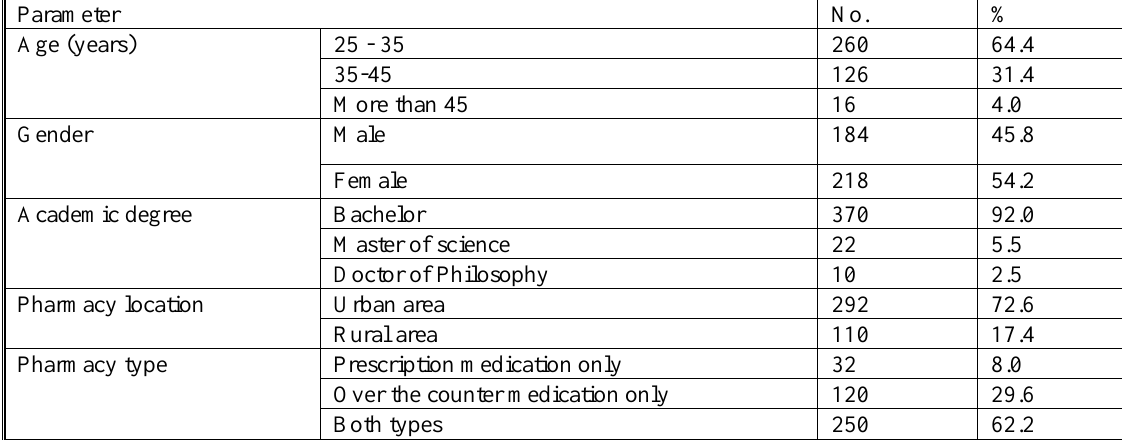
Table 2. General information of pharmacists and their pharmacies ( n = 402).